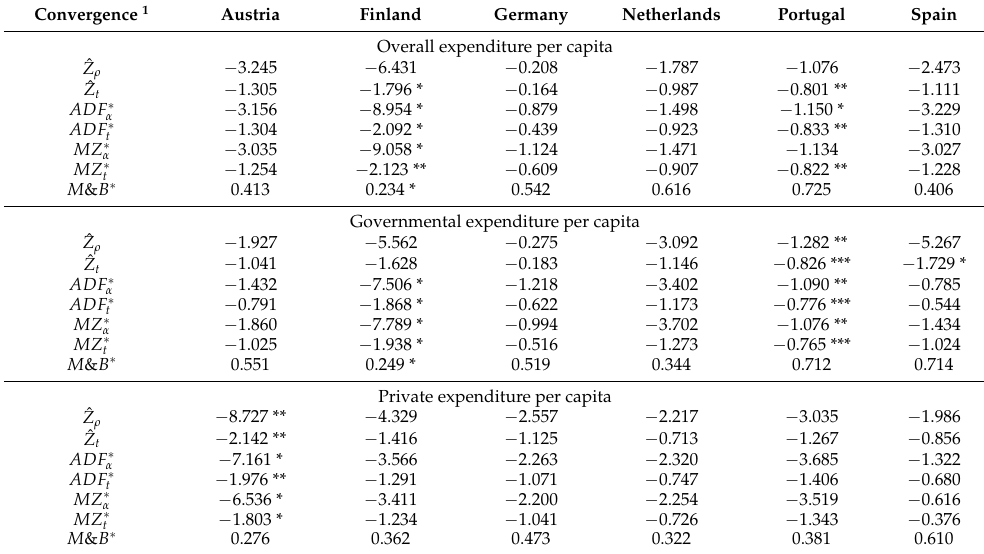
Table 2. Results for bounded unit root tests—health expenditure per